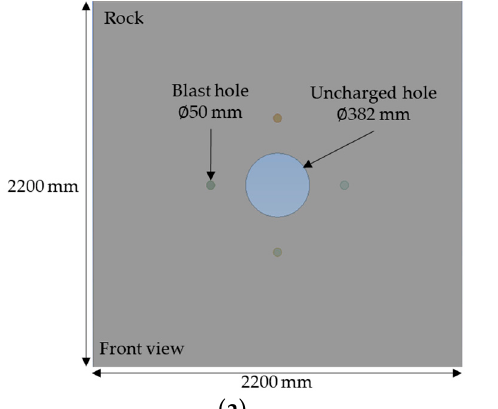
Figure 10. Geometry of the numerical simulation model for modified LLB method utilizing the deck charge technique: ( a ) front view and ( b ) side view.